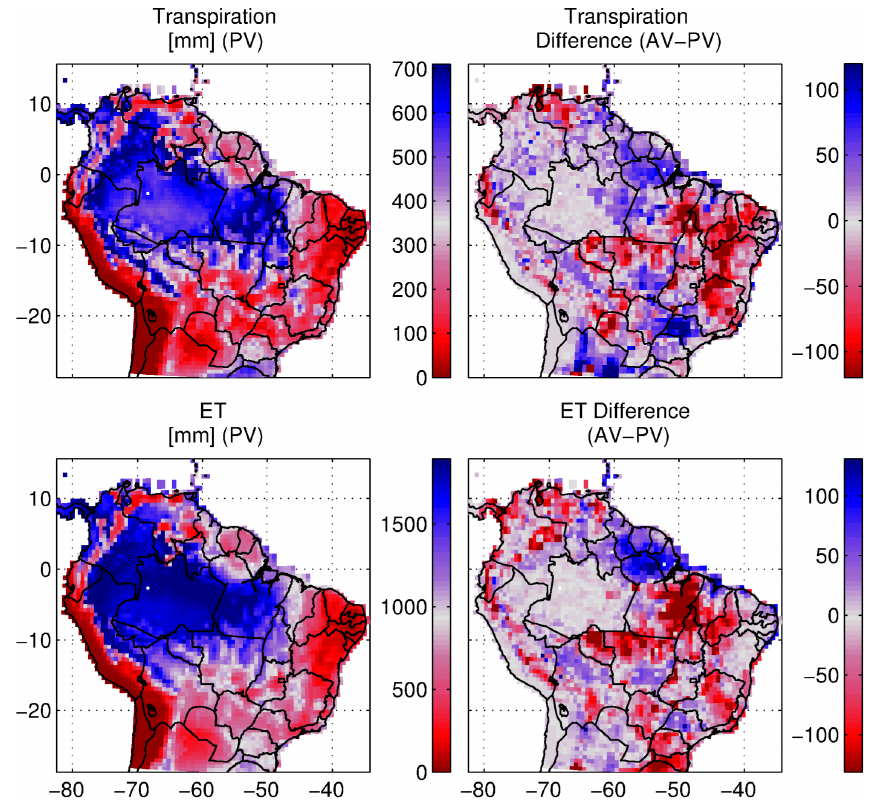
Figure 5. Left panels: mean annual transpiration and evapotranspiration in the potential vegetation (PV) scenario, from 2002 to 2005 (mm). Right panels: difference in mean annual transpiration and evapotranspiration between the actual vegetation case and potential vegetation case